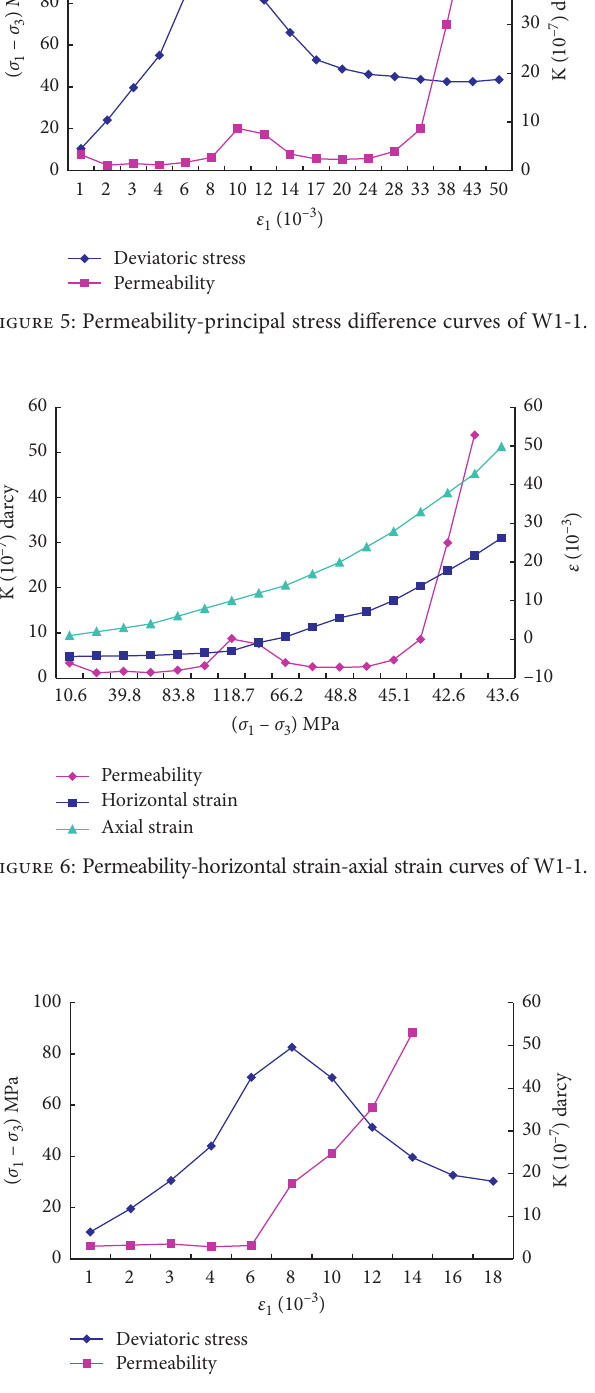
Figure 7: Permeability-principal stress difference curves of